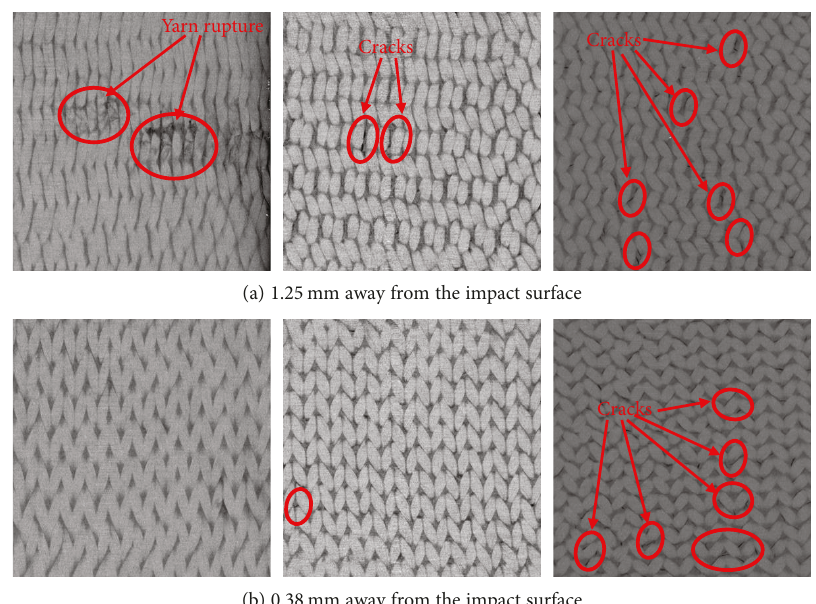
Figure 16: Comparison of X-ray images on target with di ff erent braiding angles: 20 ° (left), 30 ° (middle), and 45 °